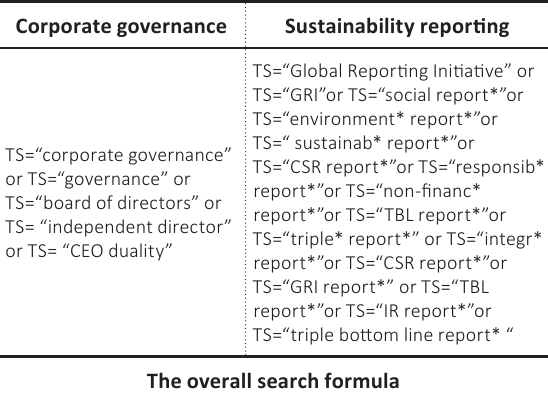
Table 2. The search formula used in the